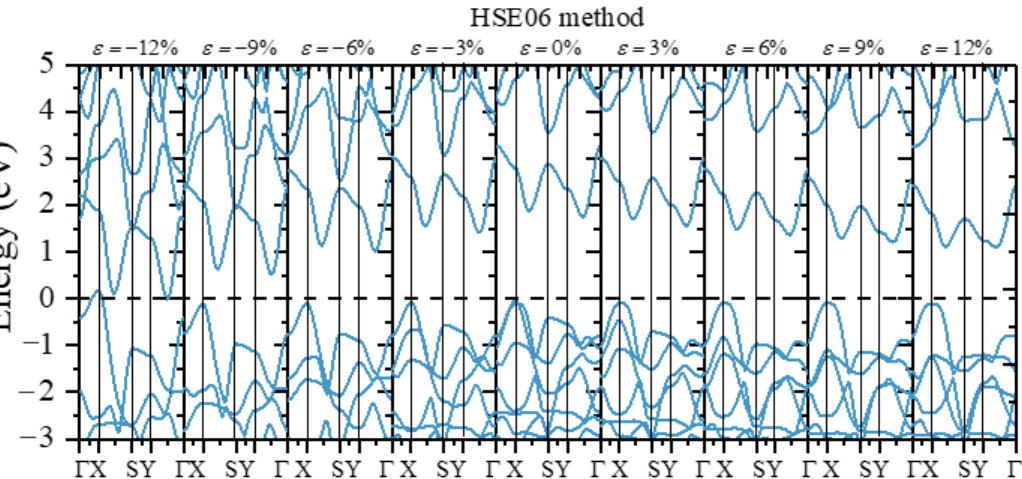
Figure 10. The band structure when different biaxial strains are applied using the HSE06 method.